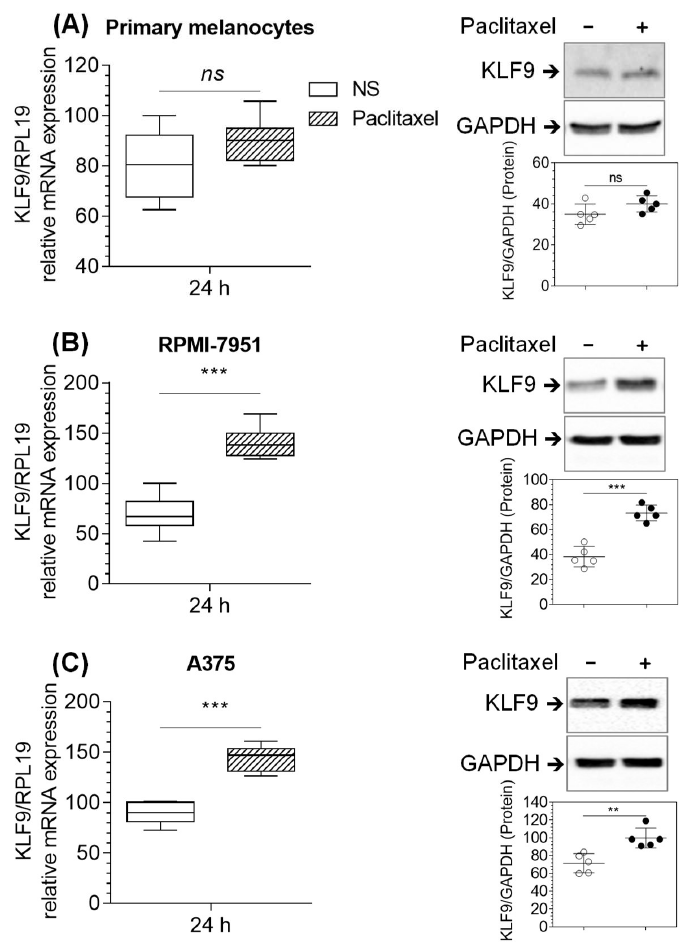
Figure 2. Paclitaxel increased the expression of KLF9 (mRNA and protein) in RPMI-7951 and A375 cells but not in primary melanocytes. RT-PCR (left panels) and Western blot analysis (right panels) of KLF9 mRNA and protein, respectively. ( A ) primary melanocytes, ( B ) RPMI-7951, and ( C ) A375 cells. For KLF9 mRNA and protein analysis, cells were treated with paclitaxel (100 nM) and harvested after 24 h for RT-PCR or Western blot, as described in the methods section. Relative quantities of KLF9-mRNA were normalized to mRNA quantities of the housekeeping gene, RPL19, within the same sample. For protein analysis, cell lysates (50 µg total protein) were electrophoresed, transblotted, and immunoprobed against KLF9 or GAPDH (loading control) antibodies. Densitometric analysis of protein bands (right bottom scatter plots) was calculated as mean differences of the densitometric arbitrary scan units of KLF9 bands normalized to GAPDH. Data ( n = 5–6), box and whiskers, left panels, and scatter plots, right panels, represent means (±SD). ns p > 0.05, ** p ≤ 0.01, *** p ≤ 0.001 vs. none-stimulated cells.